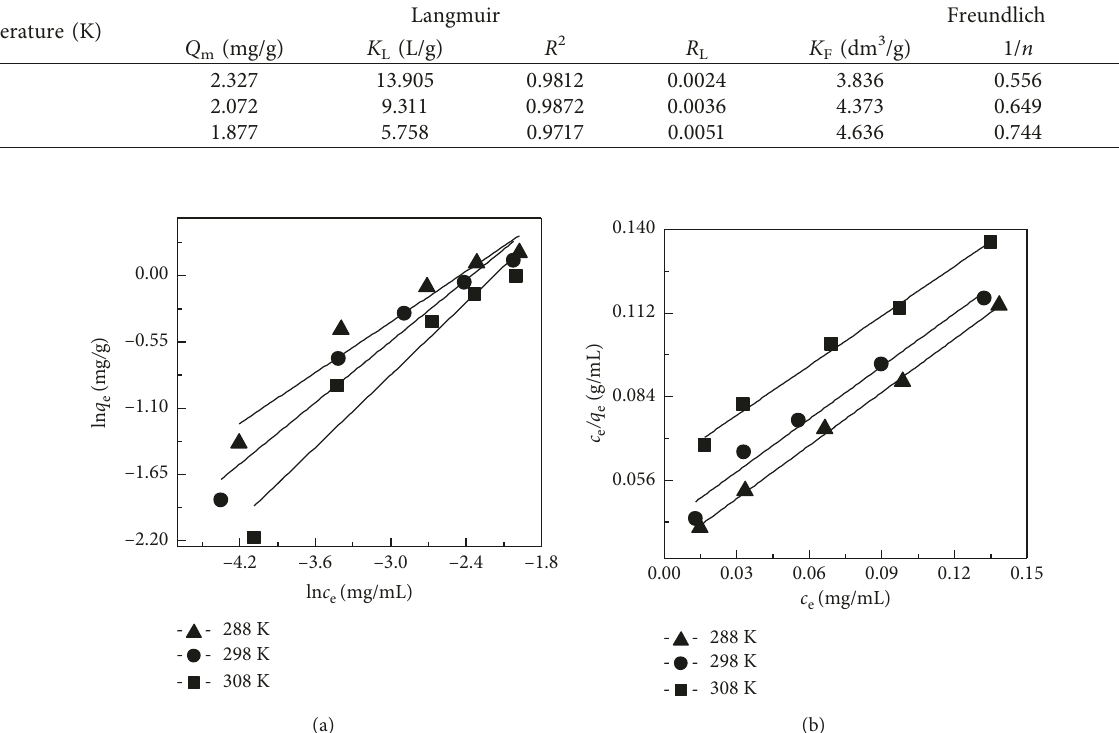
Table 3: Langmuir and Freundlich isotherm parameters of CHE on ZSM-5 at different temperatures. Langmuir Freundlich Temperature (K)